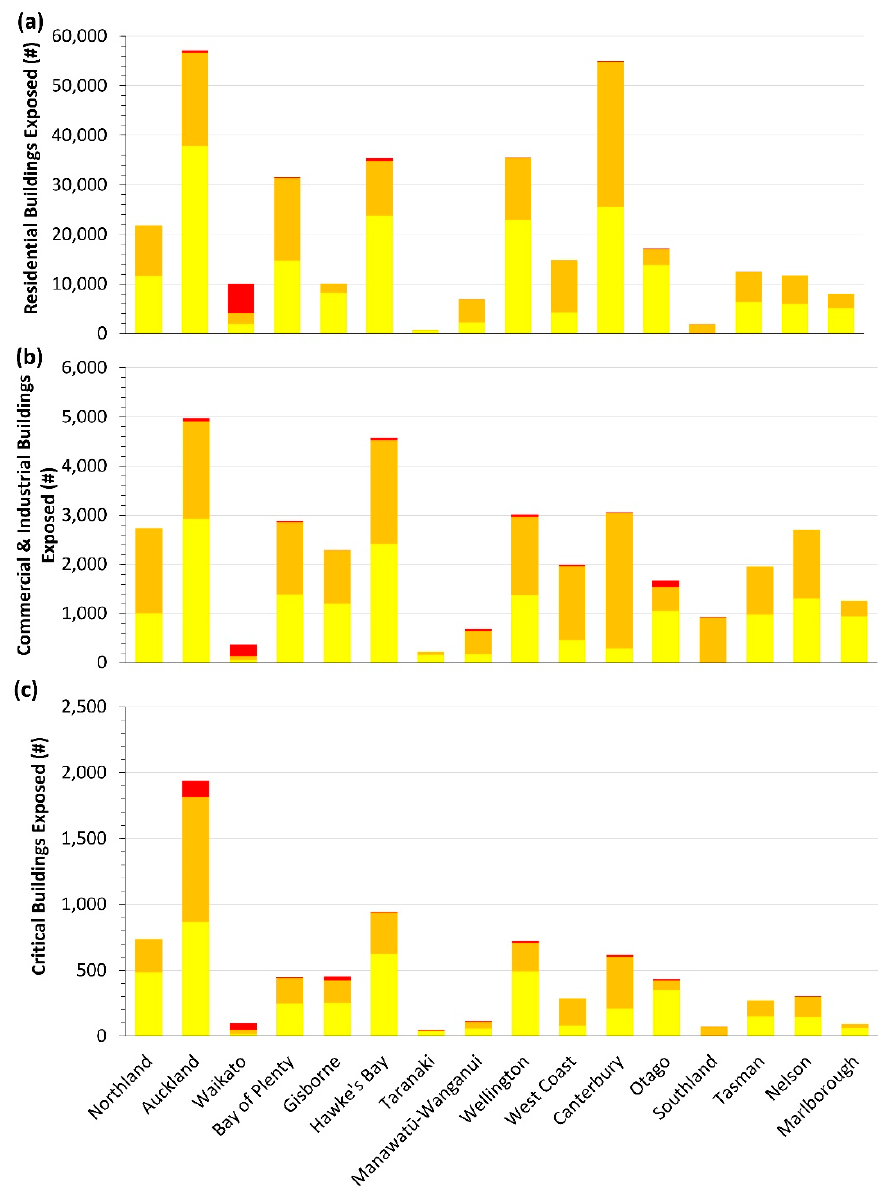
Figure 6. Regional building exposure within ‘red’, ‘orange’ and ‘yellow’ tsunami evacuation zones for ( a ) residential, ( b ) commercial and industrial, and ( c ) critical buildings.